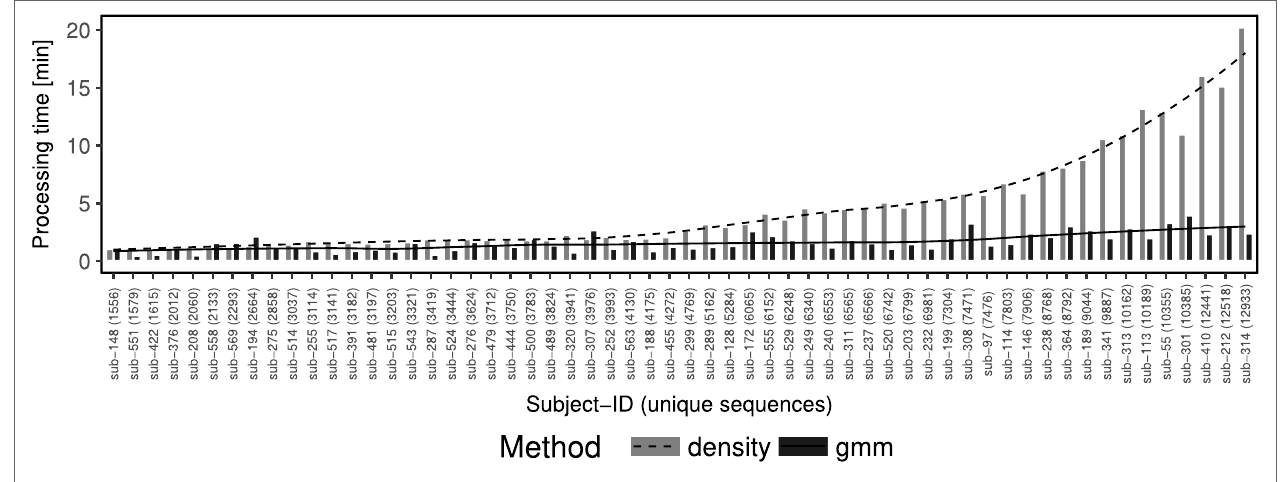
FIGURe 4 | The gmm approach is computationally efficient while the density approach run time scales exponentially. Comparison of running times ( y -axis) between density (dashed line and gray bars) and gmm (solid line and black bars) approaches performed over 58 individuals from a study of acute dengue infection (10) ( x -axis). The x -axis is ordered ascending by the number of sequences in the individual